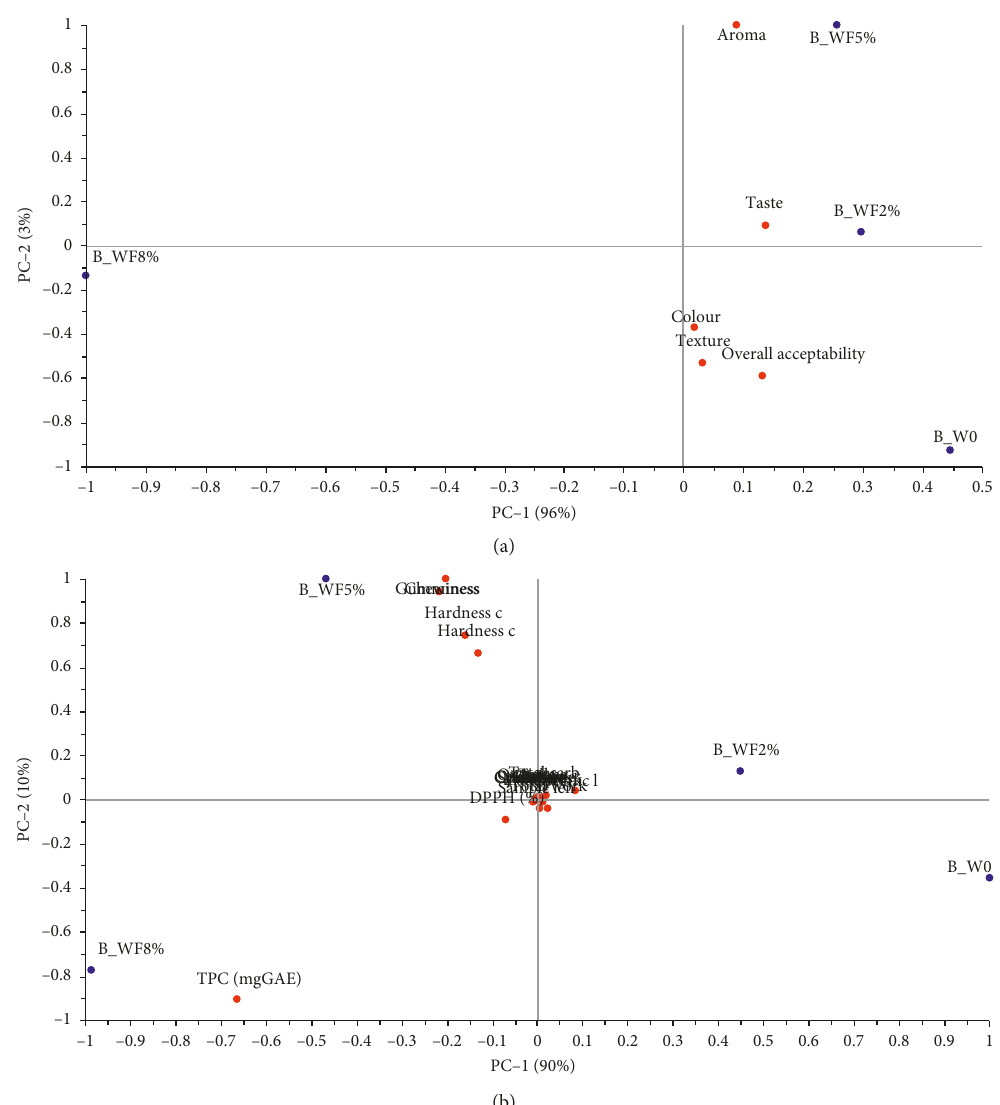
100% wheat flour+ 0% fenugreek flour; B_WF2% 98% wheat (cid:30) (cid:30)